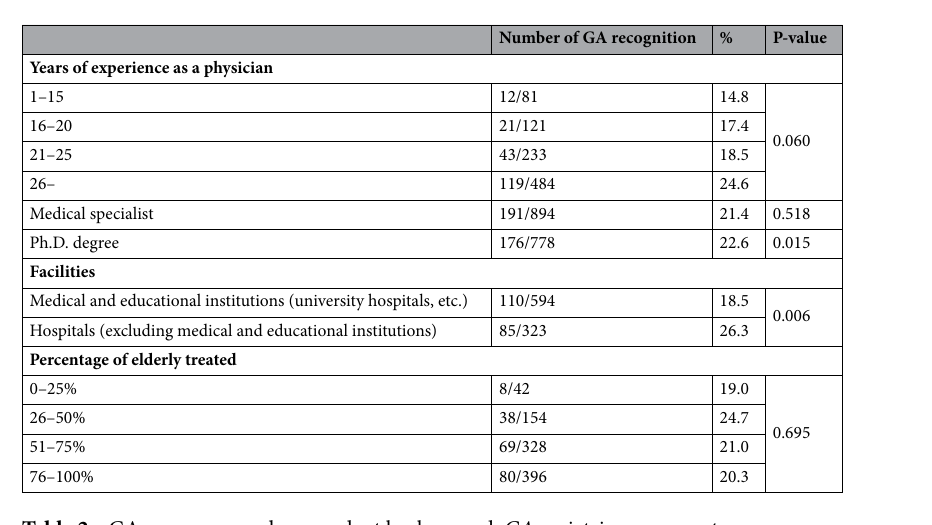
Table 2. GA awareness and respondent background. GA geriatric assessment.